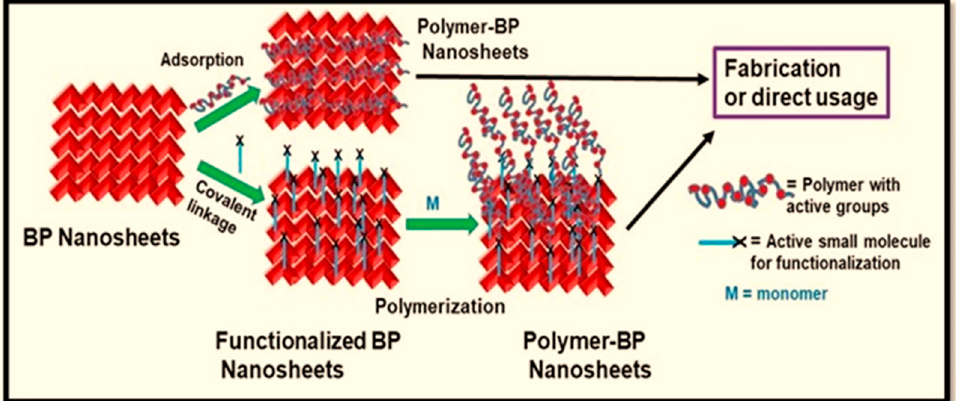
Figure 4. Synthesis of hybrids of polymers and BP nanosheets or quantum dots via solvent exfolia-